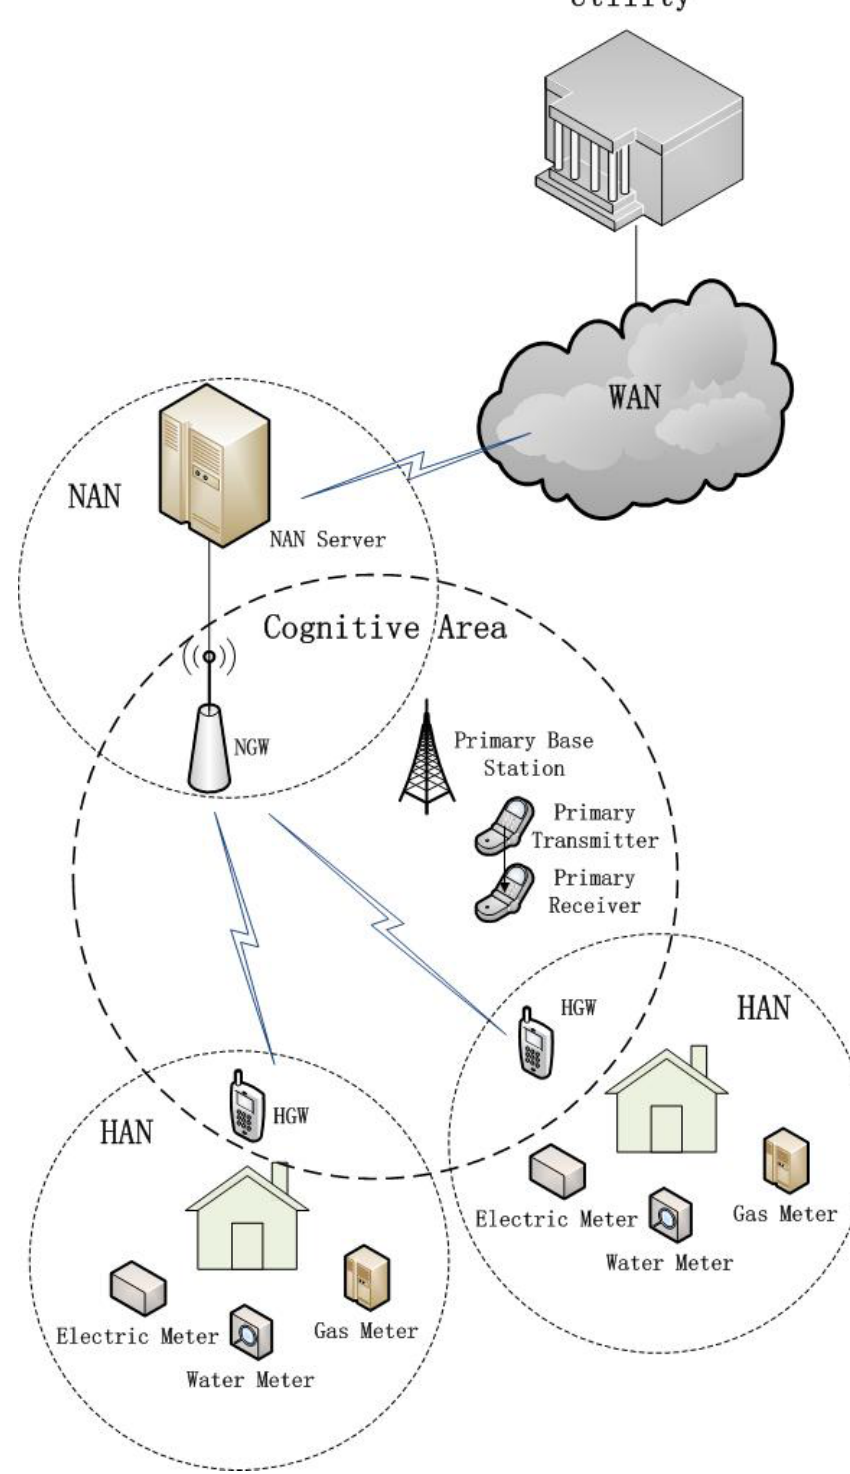
Figure 1. Architecture of the CR-enabled SG communication